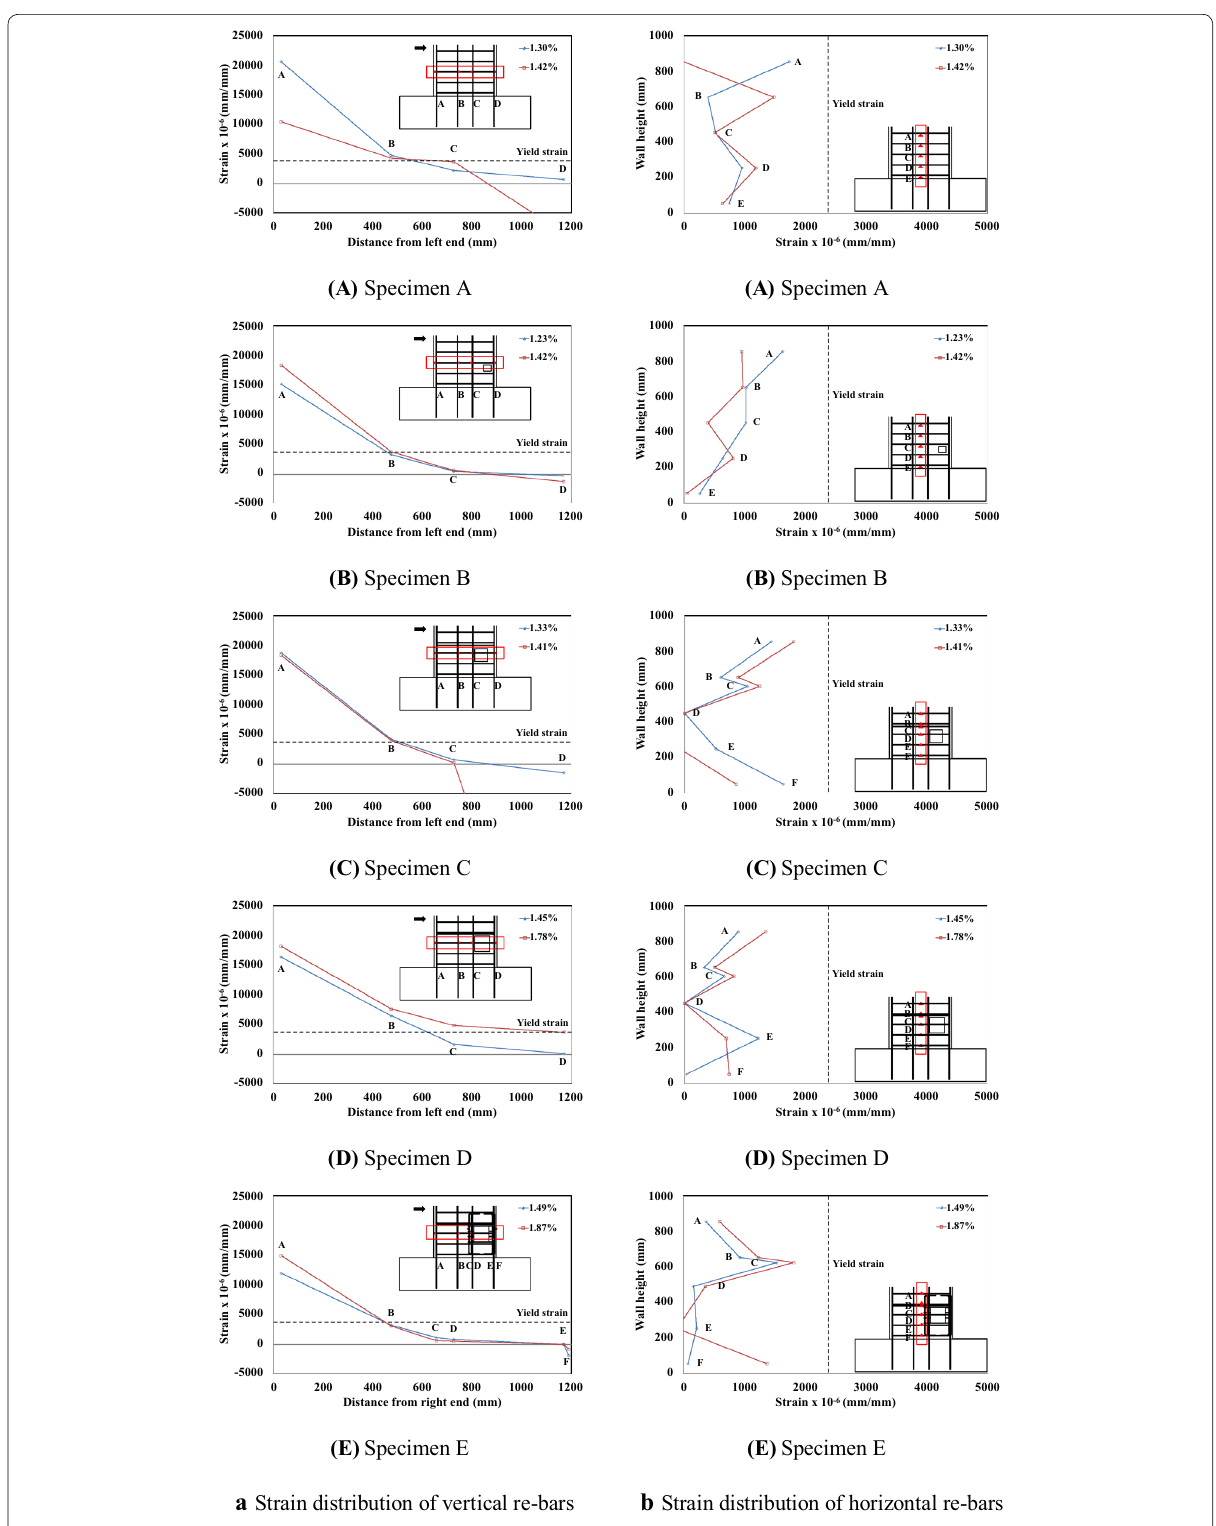
Fig. 11 Strain distribution in horizontal and vertical